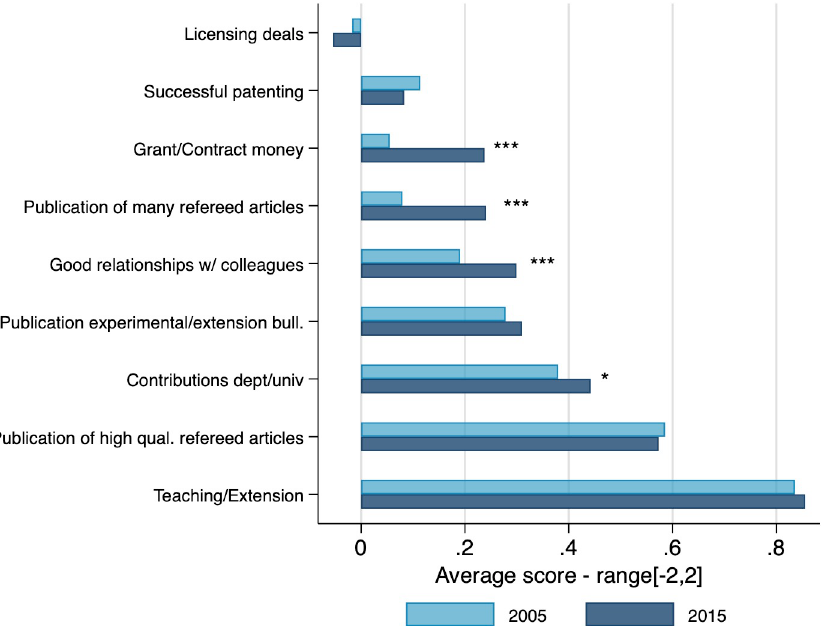
Fig 5. Faculty preferences with respect to T&P criteria. Figure displays average scores per preference criteria. Responses range from -2 (Much Less Weight) to +2 (Much More Weight). Statistical t-tests between 2005 and 2015 data within a category are shown in the graph. � : 10%, �� : 5%, ��� :1%. N =